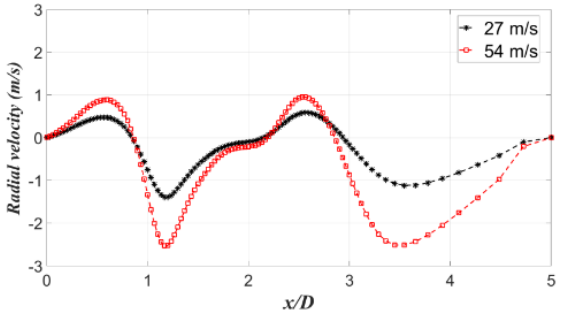
Figure 18. Radial velocity distributions at varied jet inlet velocities (z/D = 5).